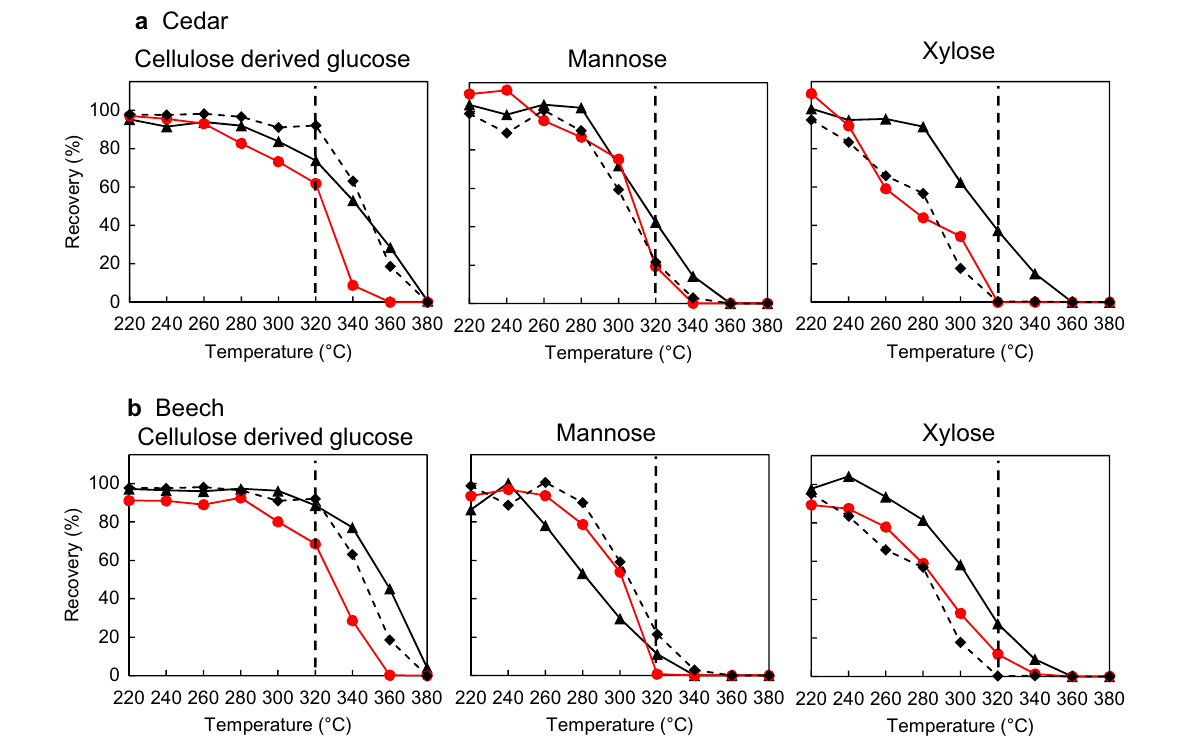
Fig. 4 Comparison of the recovery rates of hydrolysable sugars, cellulose-derived glucose, mannose, and xylose, in pyrolysis of untreated wood ( ▲ ) and holocelllulose ( ) and Whatman cellulose, beech xylan, and konjac glucomannan ( ♦ ). Dashed lines at 320 °C are inserted to facilitate